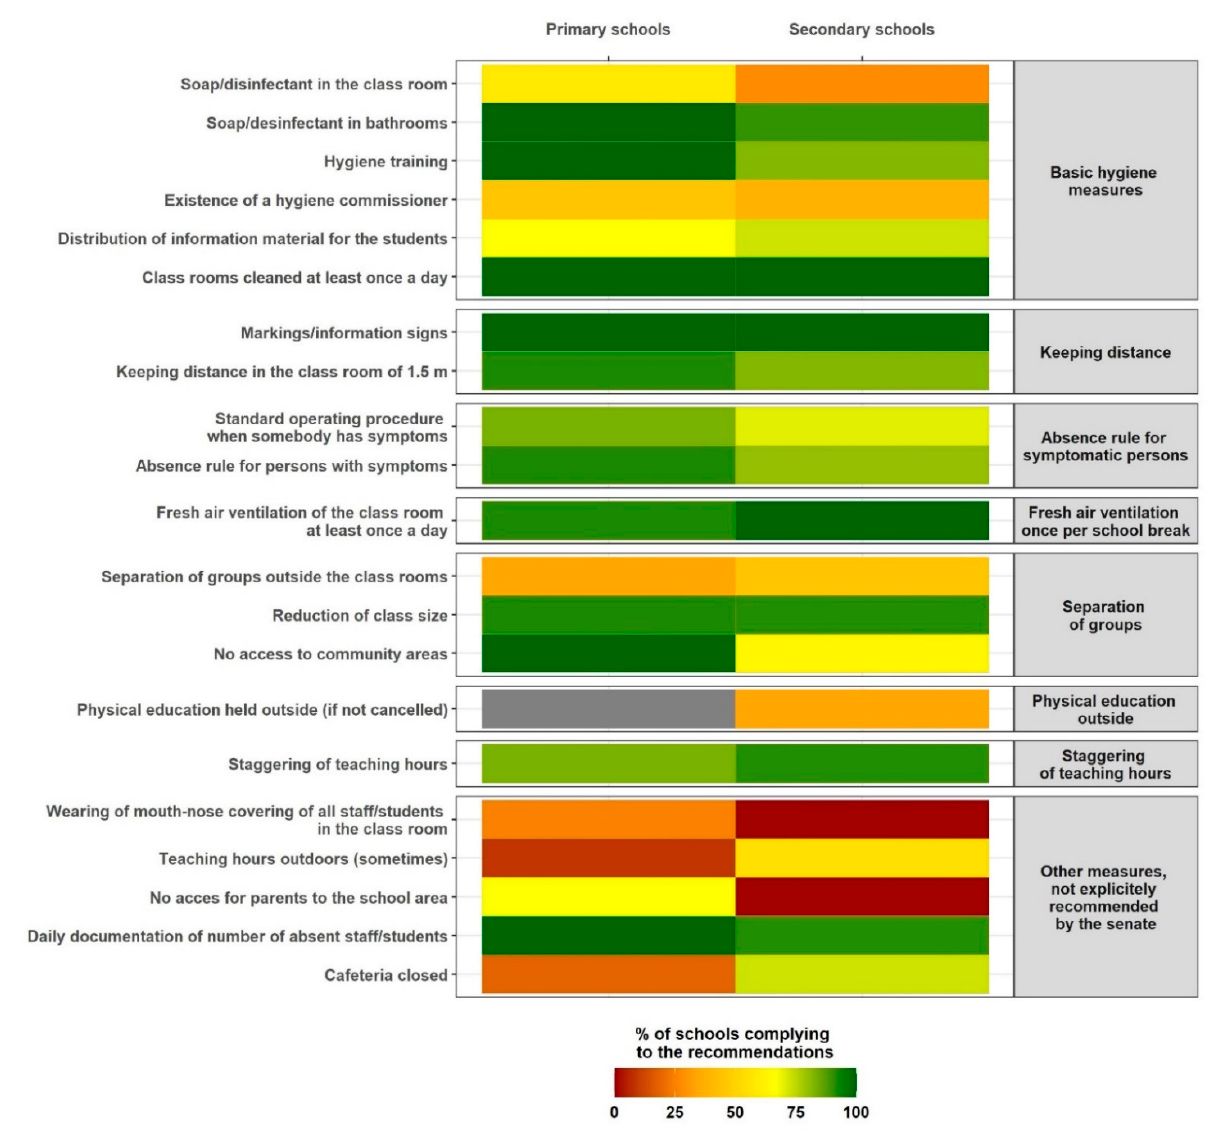
Figure 2. Heat map with percentage of implementation of the preventive measures in classes, stratified by the main aspects of the senate’s recommendations valid in June 2020.